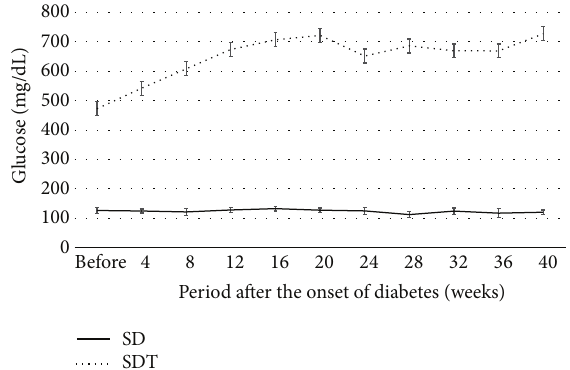
Figure 2: Blood glucose levels of the study animals. The mean blood glucose levels of the SD rats are significantly lower than those of the SDT